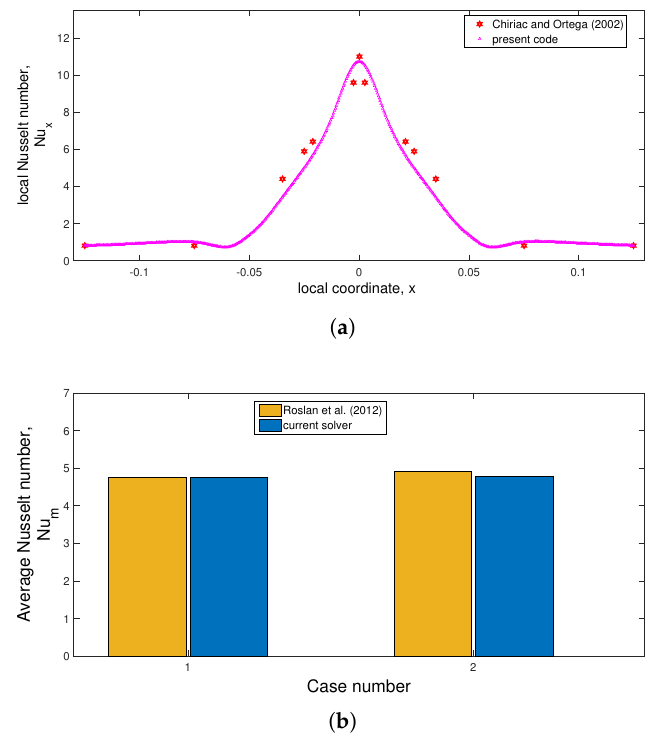
Figure 3. Code validation studies: ( a ) Local Nu distribution comparisons with Ref. [49] at Re = 250 for confined slot jet impingement system and ( b ) average Nu comparisons with Ref. [50] in a differentially heated cavity under the effects of RCC (Case 1 − R = 0.1, Ω = 500 and Case 2 − R = 0.2, Ω =